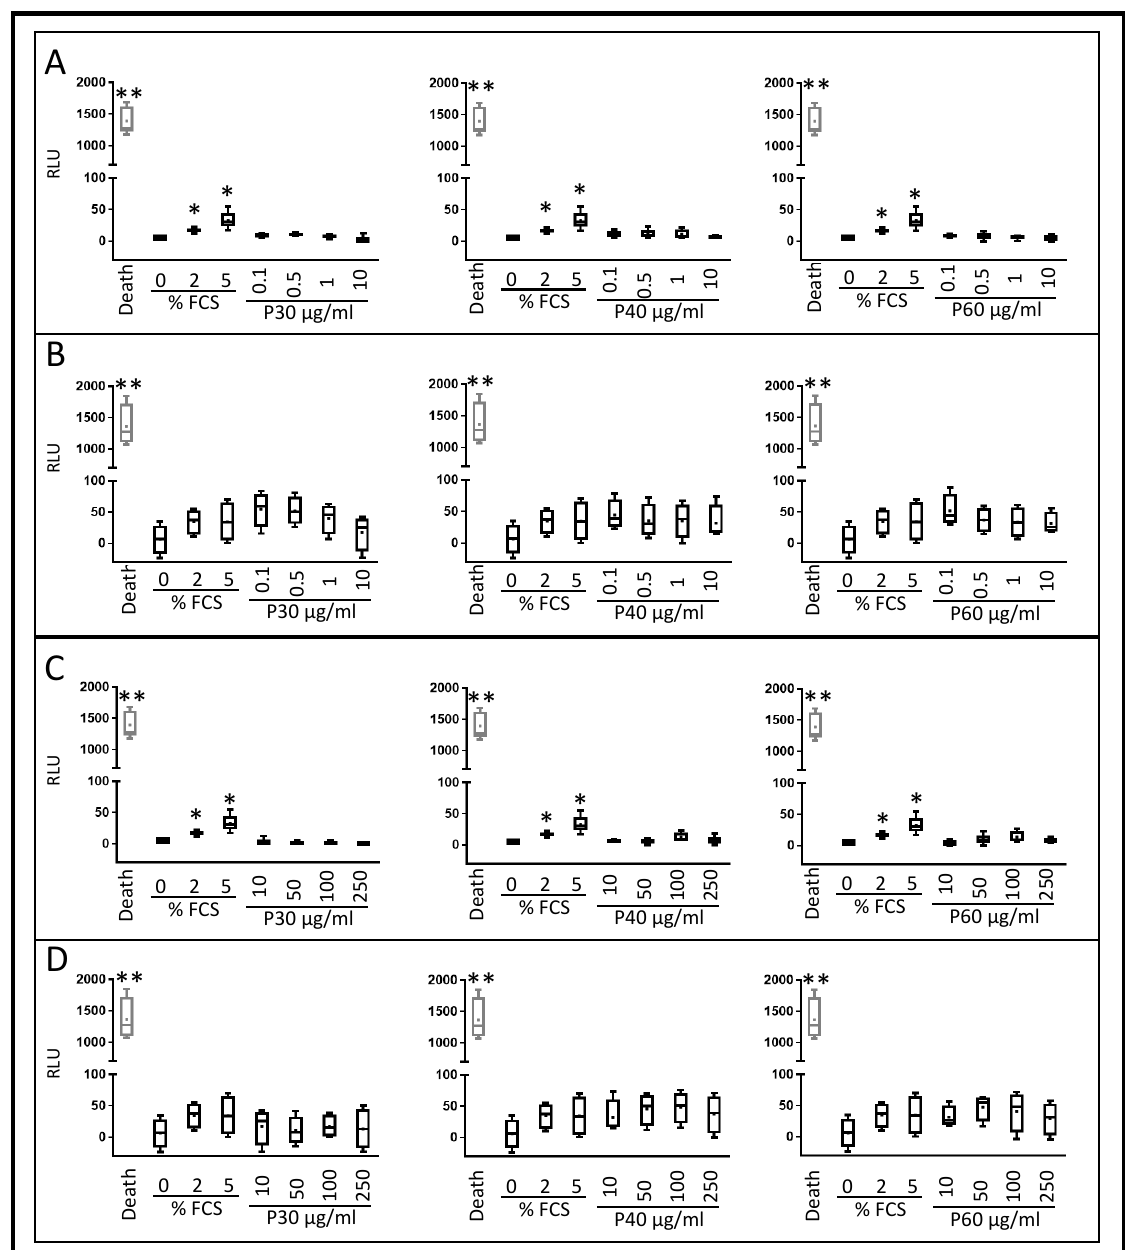
Figure 1. Promerim ® 30, 40, and 60 have no cytotoxic effect on equine articular chondrocytes cultured in hypoxia. Equine articular chondrocytes were amplified and seeded at P3. At 80% of confluency, the cells were treated with Promerim ® hydrolysates at several concentrations (0.1, 0.5, 1, and 10 µg/mL) ( A , B ) and (10, 50, 100, 250 µg/mL) ( C , D ) in the absence (0% ( A , C )) or presence of 2% fetal calf serum (FCS) ( B , D ) and then cultured for 72 h in hypoxia. Controls with 0, 2, and 5% of FCS were included, as well as a death control (triton-induced death). The levels of adenylate kinase were measured in the media after 72 h of culture (Toxilight kit, Interchim). Data are represented as box plots ( n = 5). Statistical analyses were performed using the Mann–Whitney test (* p < 0.05, ** p < 0.01),and the 2% and 0% FCS conditions were used as references. P30, P40, and P60: Promerim ® 30, Promerim ® 40, and Promerim ®